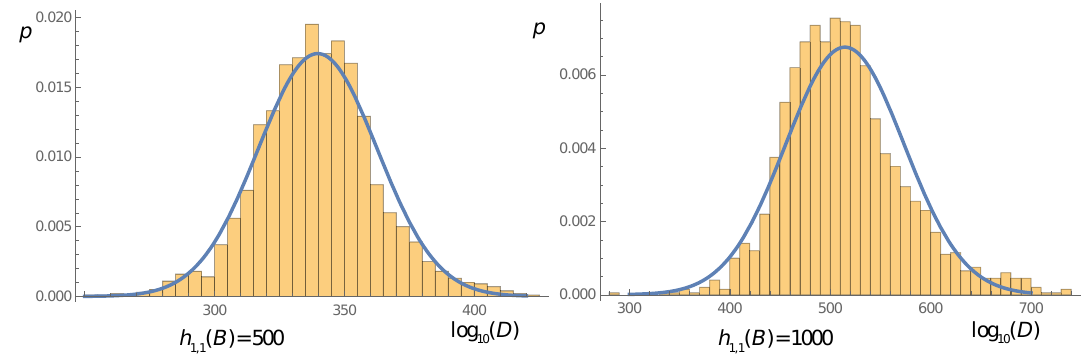
Figure 11 . Distribution of the logarithm of the dynamic weight factor D at h 1 ; 1 ( B ) = 500 and 1,000 and the (cid:12)tting curve using a normal distribution. For h 1 ; 1 ( B ) = 500, the mean value of log ( D ) is 339.707 while the standard deviation is 22.9357. For h 1 ; 1 ( B ) = 1 ; 000, the mean value 10 of log ( D ) is 514.694 while the standard deviation is 10